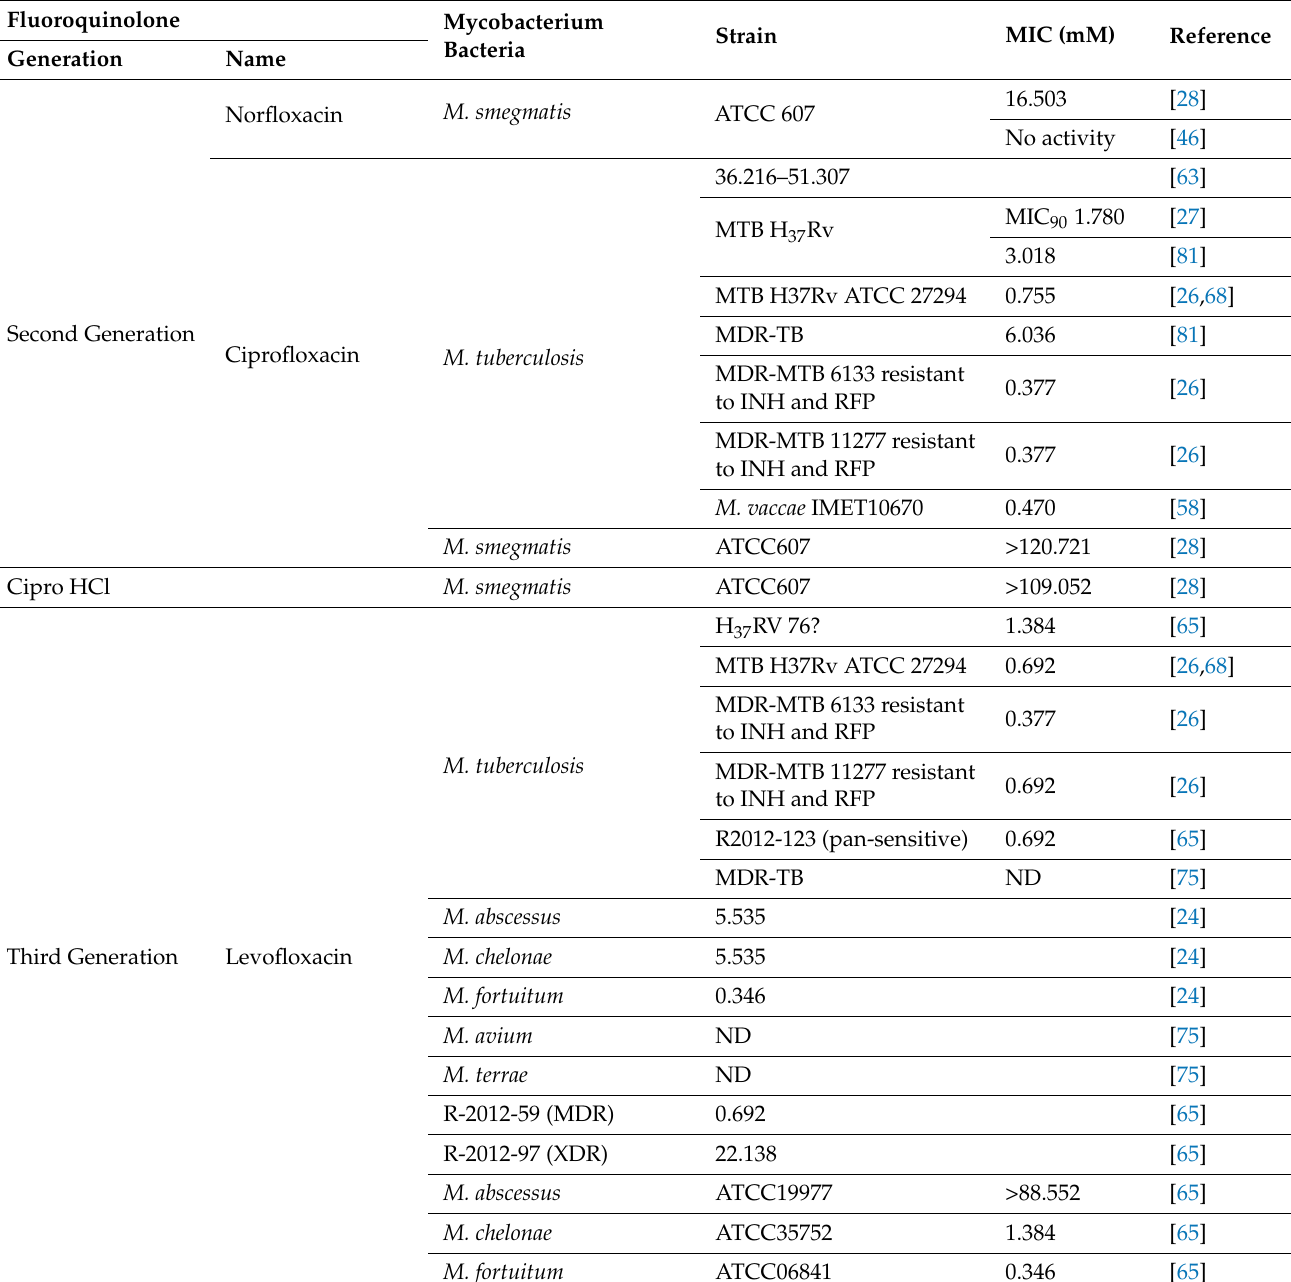
Table 5. Fluoroquinolones’ antimycobacterial